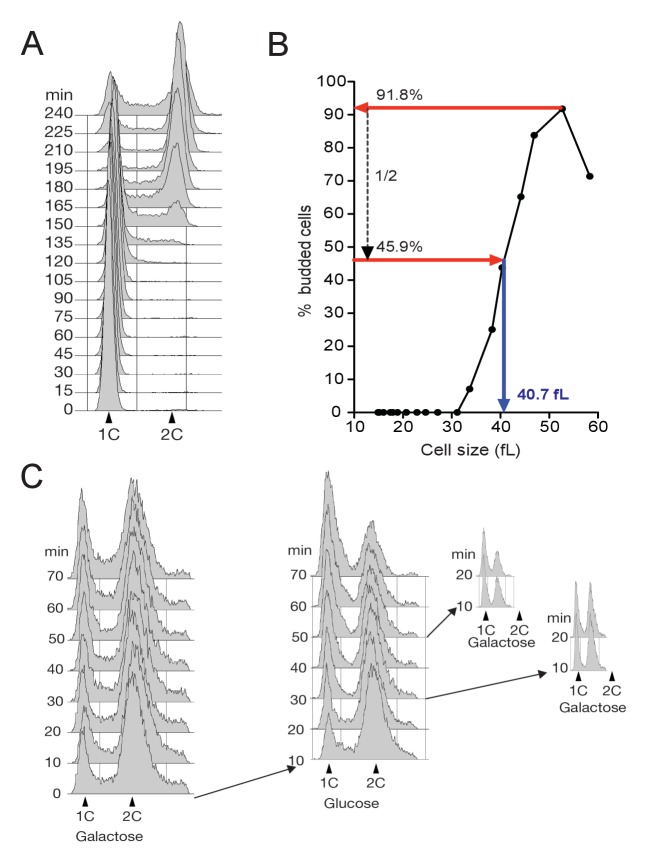
FACS profiles and determination of median cell size at budding(A) Cell cycle progression determined by FACS analysis of DNA content of elutriated early IGO1-myc cells (E4996) released in SC-D at 30°C (corresponding to Figure 2A). (B) Calculation of cell size at half-maximal budding. Median cell volume and budding index are measured at each time point during a synchronous cell cycle after elutriation. Normalized cell size at budding is calculated as the median cell size when the population reaches half-maximum budding. (C) FACS profiles of experiment shown in Figure 2B.